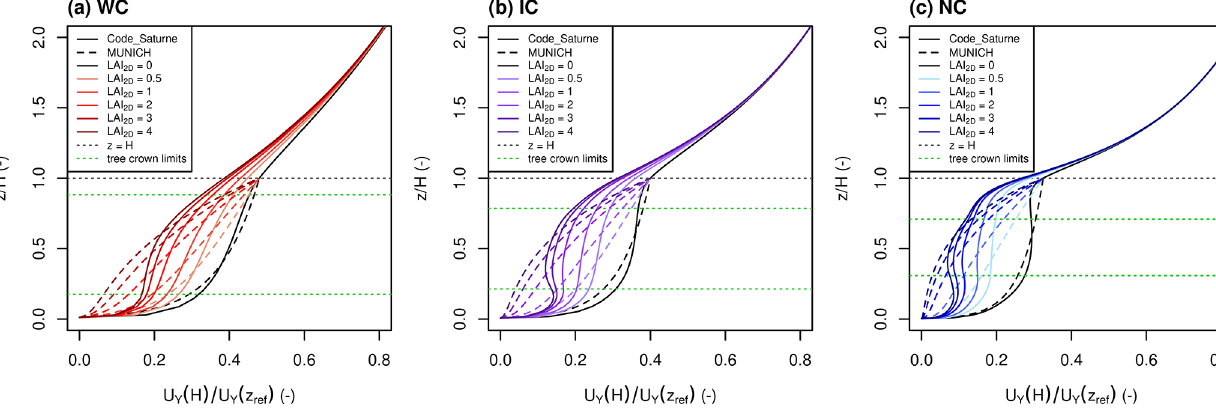
Figure 6. Comparison of Code_Saturne (solid lines) and parameterized (dotted lines) vertical wind profiles. The profiles in a treeless canyon are in black and darker colors correspond to increasing LAI 2D . For the three canyons, h/H ≈ 0 . 5 and CVF ≈